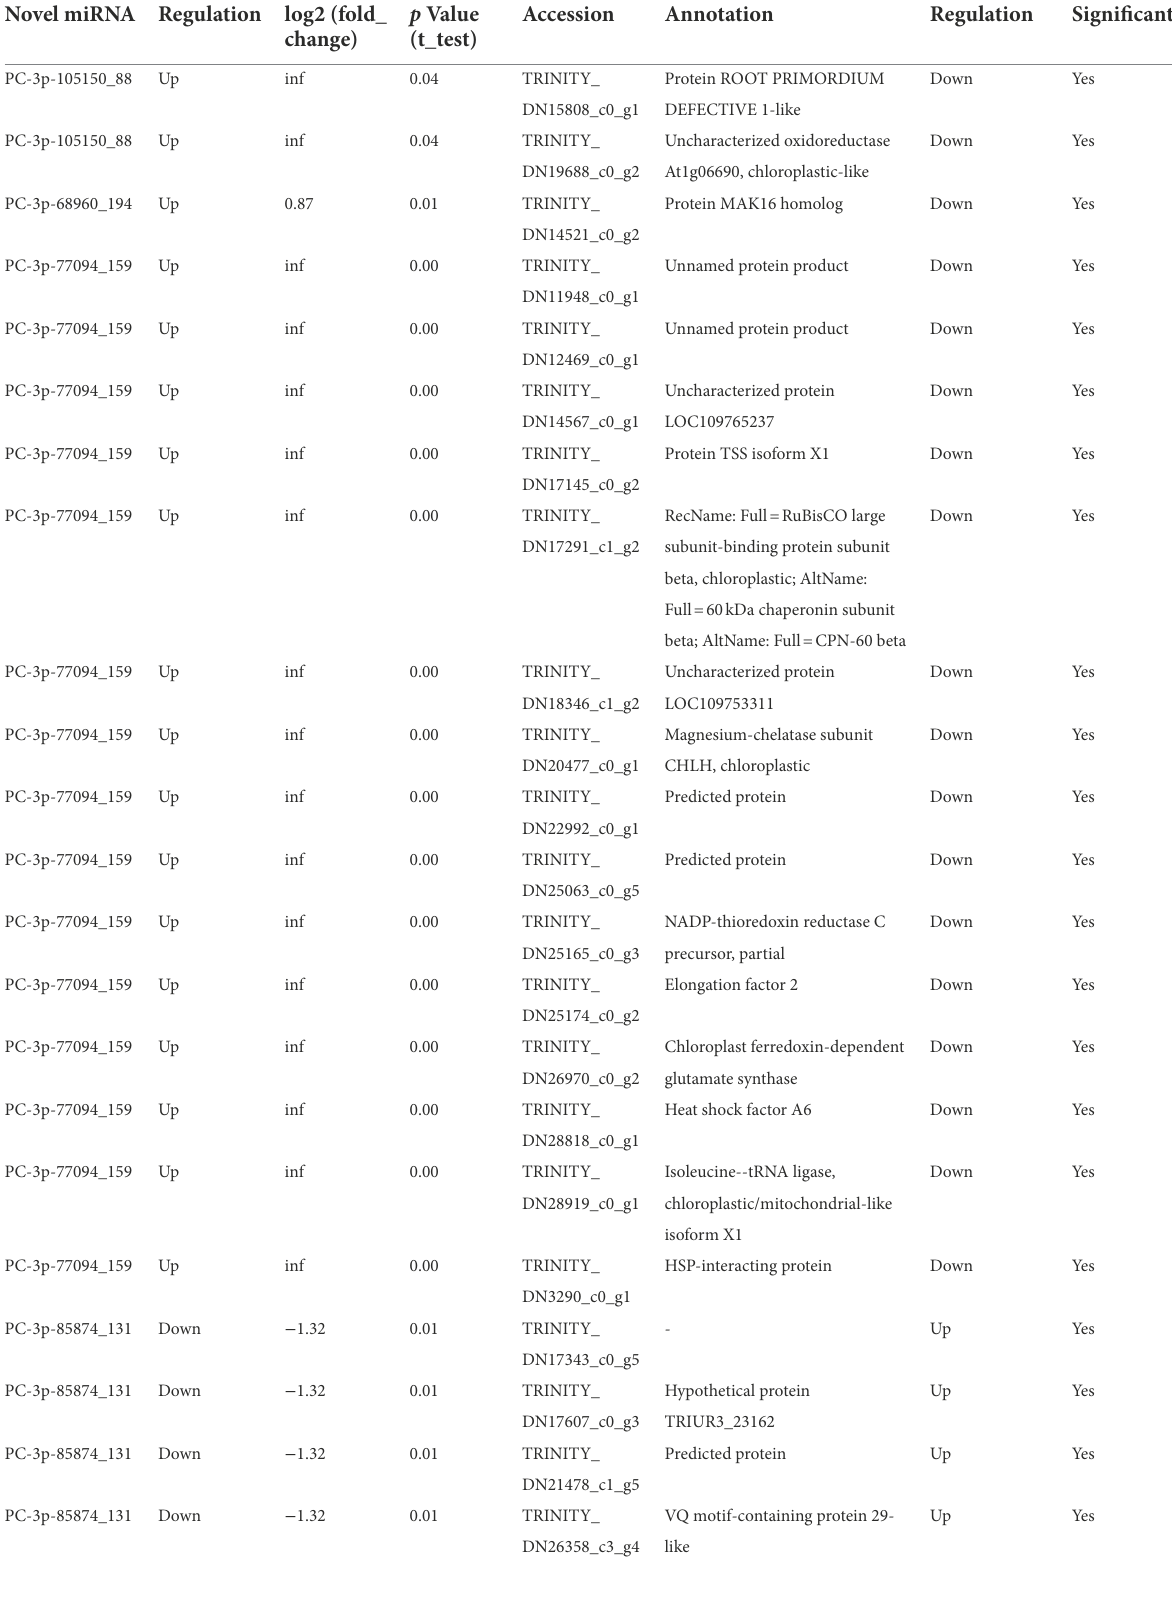
TABLE 3 Differentially expressed novel miRNA and differentially expressed target genes. Novel miRNA Regulation log2 (fold_